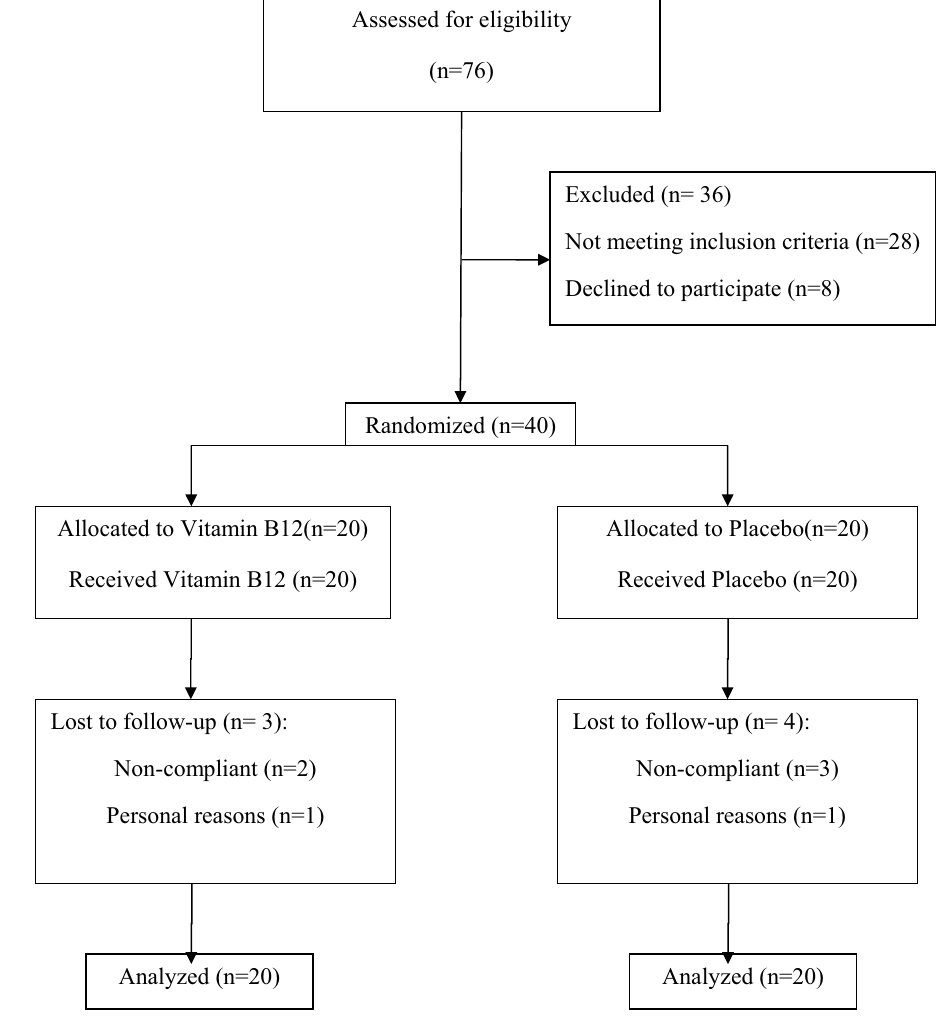
Figure 1. Flowchart of patients’ recruitment.